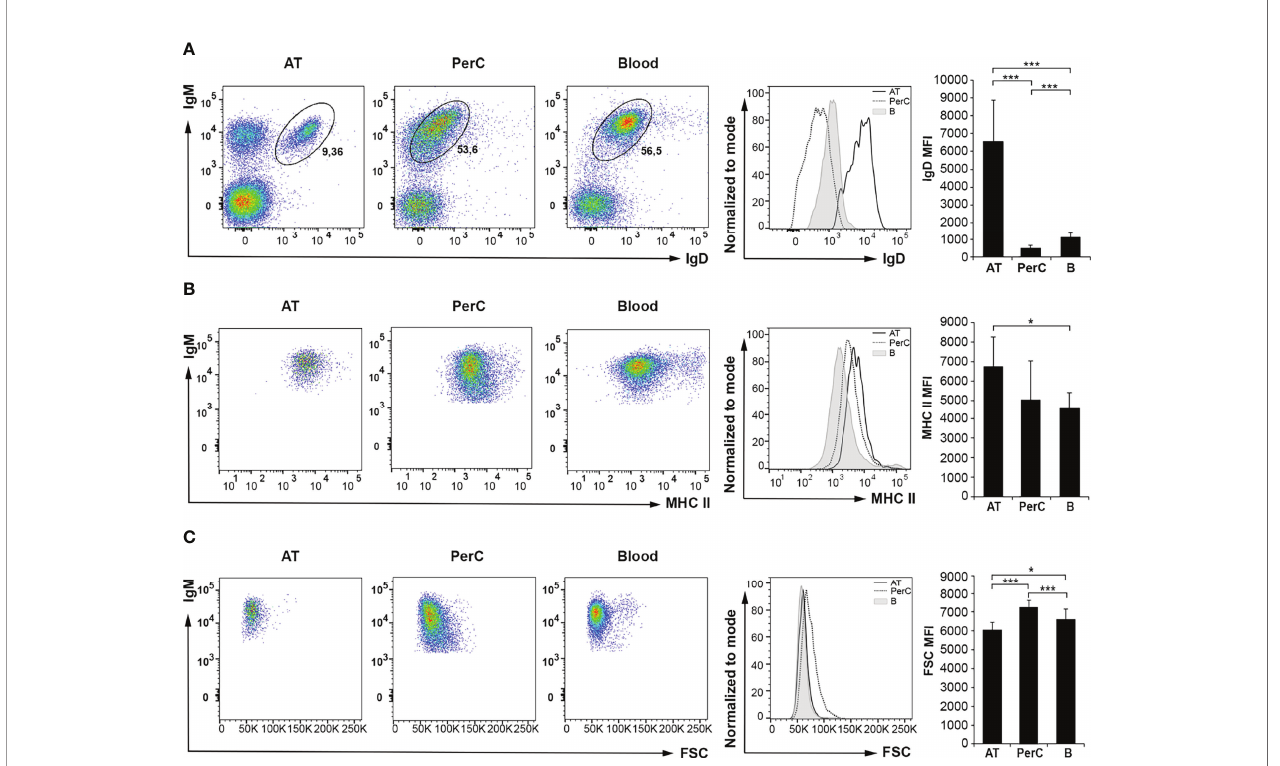
FIGURE 2 | Flow cytometry analysis of IgD and MHC II surface expression levels and cell size of IgM + IgD + B cells in rainbow trout AT compared to peritoneal cavity (PerC) and blood IgM + IgD + B cells. Leukocytes isolated from AT, PerC and blood were labeled with mAbs against trout IgM, IgD and MHC II and analyzed by fl ow cytometry. (A) Representative dot plots with IgM and IgD (A) or MHC II (B) fl uorescence intensities from each tissue are shown, along with an histogram with IgD (A) or MHC II (B) surface expression levels on IgM + IgD + B cells from tissues of one representative fi sh, and the corresponding graph showing the mean fl uorescence intensity (MFI) values (mean + SD; n = 8 fi sh). (C) Representative dot plots showing IgM and FSC values of IgM + IgD + B cells in each tissue are shown, along with an histogram with FSC values of IgM + IgD + B cells from one representative fi sh, and the corresponding graph showing FSC MFI values (mean + SD; n = 8 fi sh). AT, Adipose tissue; PerC, Peritoneal cavity; B, Blood. Asterisks denote signi fi cantly different values between indicated groups (*p ≤ 0.05 and ***p ≤